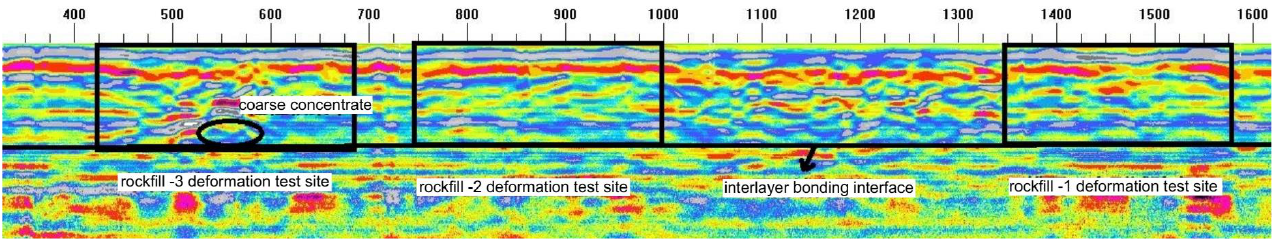
Figure 7. Radar detection results of the cemented rockfill (G–G’ line).